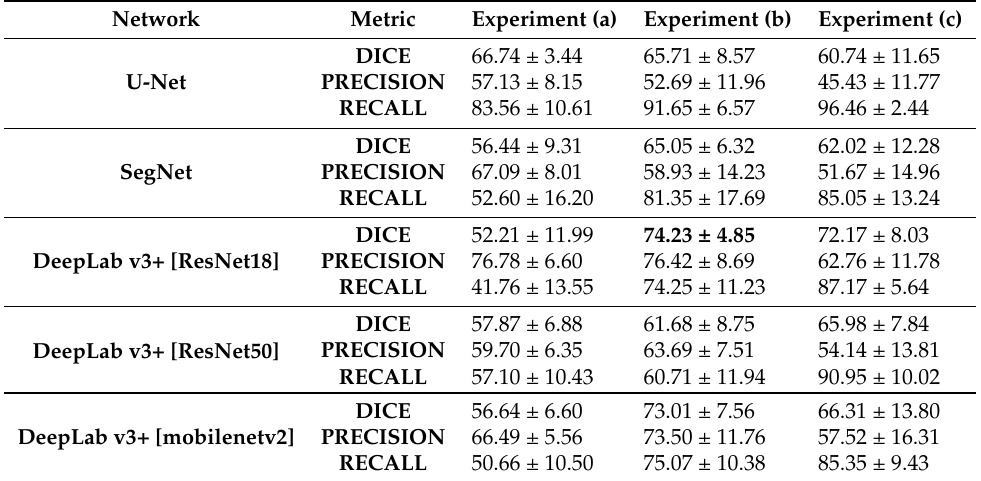
Table 2. Performance comparison between considered network architectures for semantic segmentation. Network